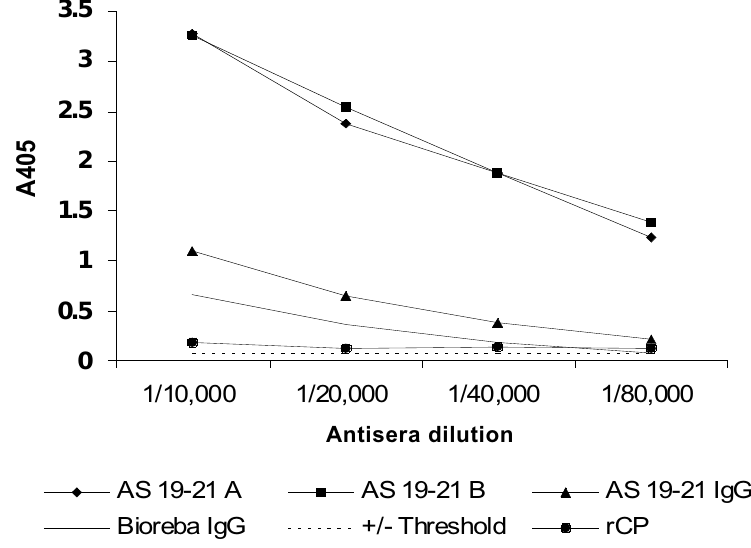
Fig. 2. Detecting ability of antisera and IgG produced against bacterially expressed CP in IDAS-ELISA. AS 19-21 A and B - crude antisera from two rabbits A and B tested against infected (isolate CTV 19) plant sap. AS 19-21 IgG - immunoglobulin purified from AS 19-21 B, tested against infected (isolate CTV 19) plant sap. Bioreba IgG - immu- noglobulin from a commercial kit, tested against infected (isolate CTV 19) plant sap. rCP - antisera AS 19-21 A, tested against the purified recombinant protein (1 µ g ml -1 ). The dilutions at which the antisera were assayed are indicated. Absorbancy readings were done after 30 minutes of incubation with the enzyme substrate. The values obtained with the negative controls ranged from 0.09 to 0.17 and were